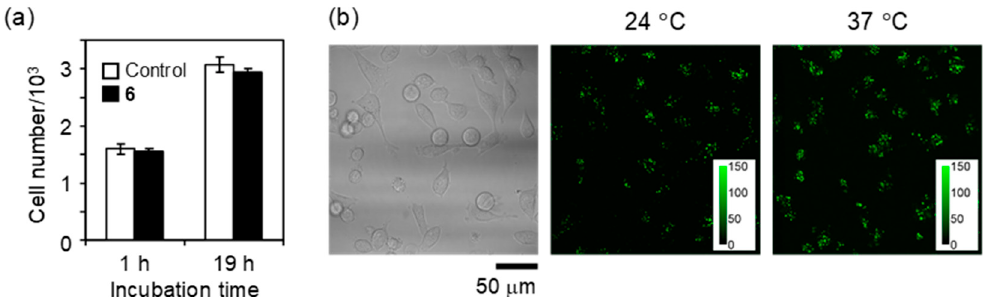
Figure 8. Non-cytotoxicity and long-term functionality of NANOGEL- 6 in live HeLa cells. ( a ) Growth of HeLa cells containing NANOGEL- 6 and none (control) (mean ± s.d.); ( b ) Transmitted light image at 37 °C (left) and confocal fluorescence image (excitation: 458 nm; emission: 500–600 nm) at 24 °C (middle) and 37 °C (right) at 24 h after the introduction of NANOGEL- 6 into the cells. Color bars in the fluorescence images indicate the fluorescence intensity (arbitrary unit).